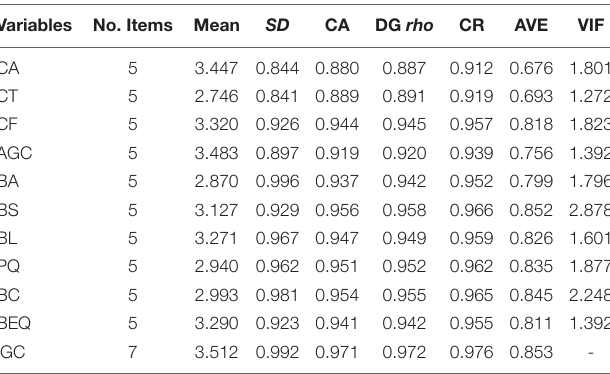
TABLE 3 | Reliability and